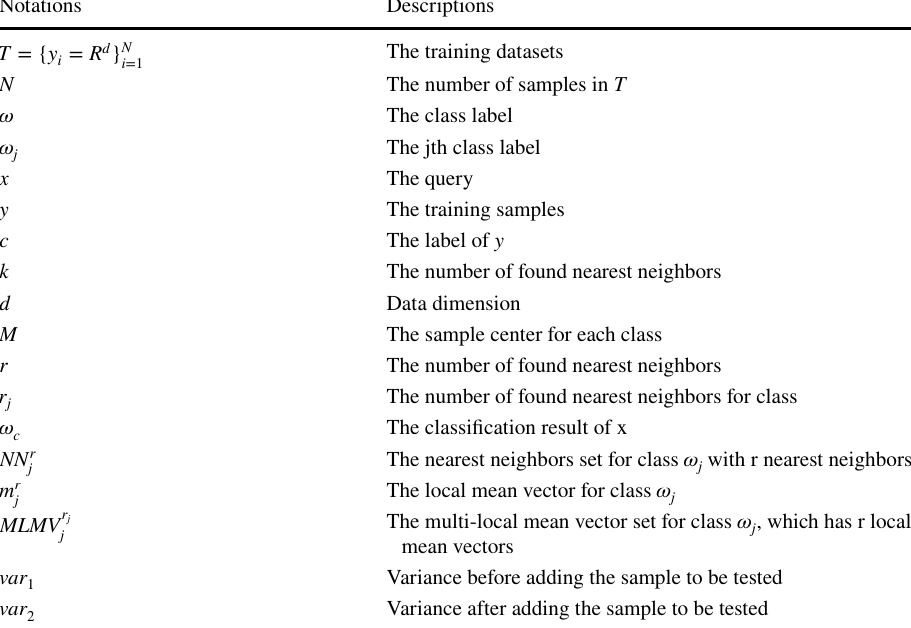
Table 4 Abbreviations